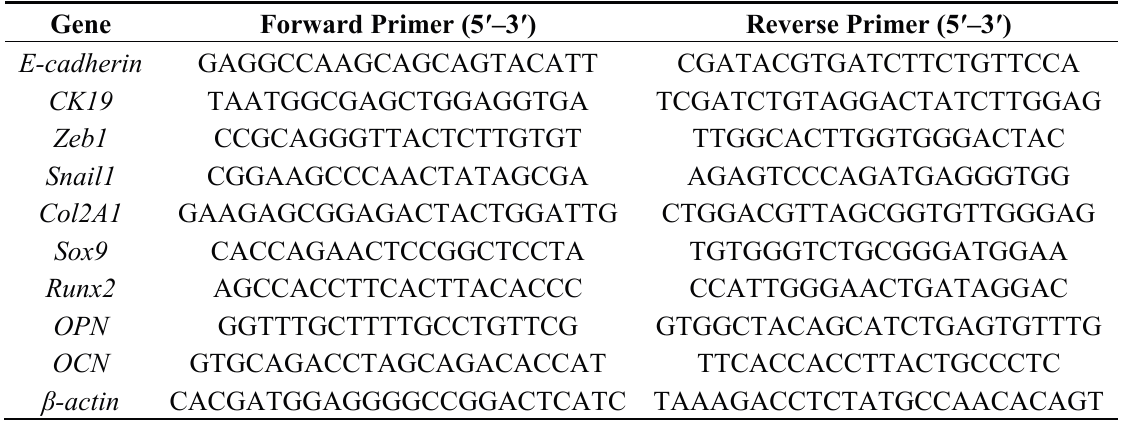
Table 1. Sequences of rat primers for real-time RT